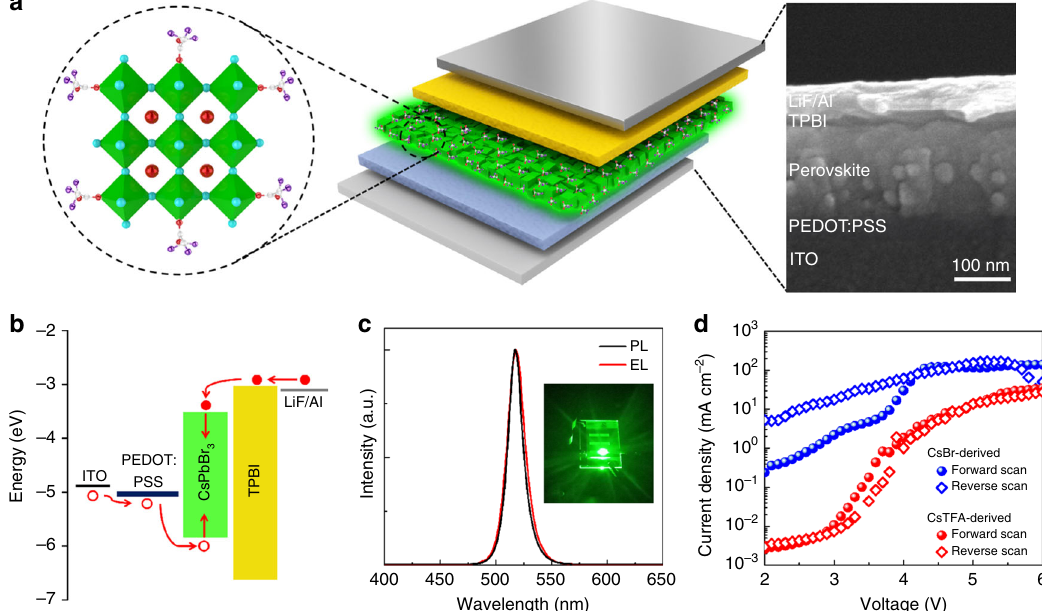
Fig. 6 Device structure of PeLEDs. a Device structure and a corresponding cross-sectional TEM image of the multi-layer PeLEDs: ITO/PEDOT:PSS (40 nm)/CsPbBr 3 (200 nm)/TPBI (20 nm)/LiF (1 nm)/Al (100 nm). b Schematic fl at-band energy diagram of the PeLED; the energy levels for PEDOT:PSS and TPBI are taken from reference 6 . c Normalized PL spectrum of the CsPbBr 3 fi lm, and EL spectrum of the PeLED at an applied voltage of 5.5 V. Inset: The photograph of the operating device with an emitting area of 2 mm × 2 mm. d J – V hysteresis of PeLEDs based on CsBr(1.7)- and CsTFA(1.7)-derived